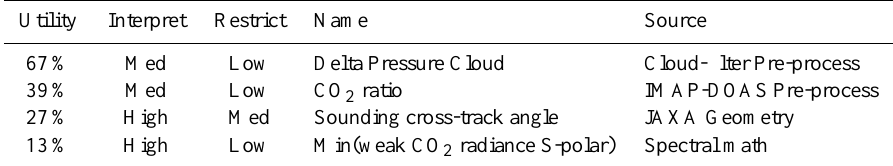
Table 3. Features chosen by the genetic algorithm to reduce scatter over Sea (Glint mode).